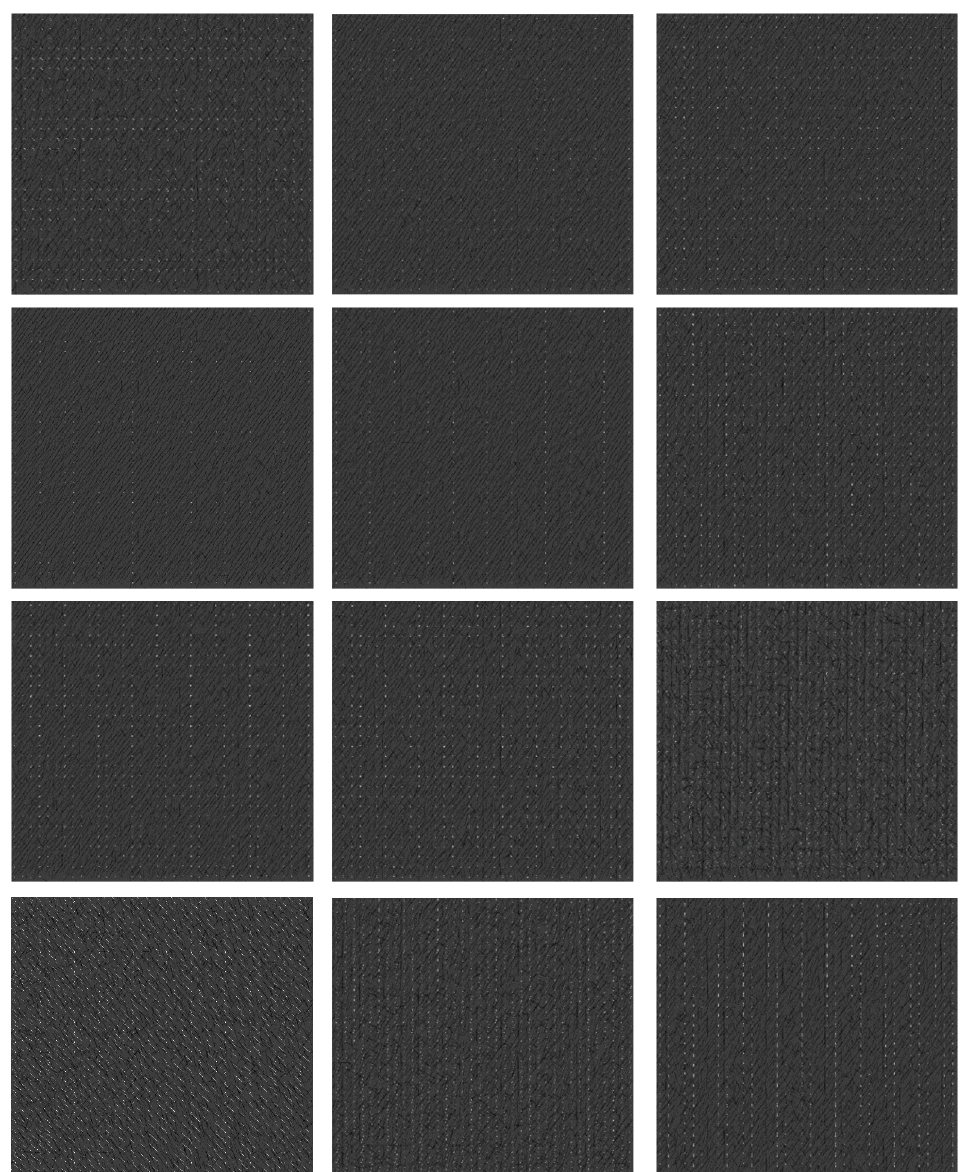
Figure 15. Twelve different blur kernels in Kohler dataset.